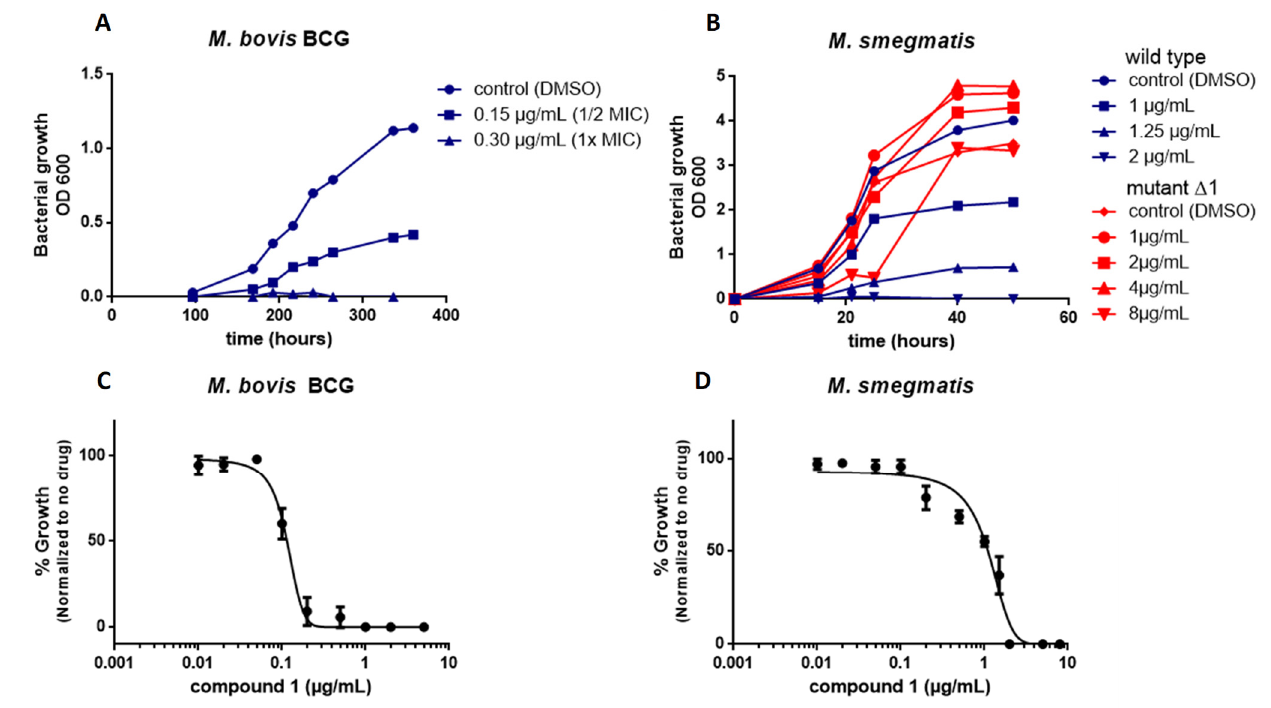
Figure 2. Compound 1 inhibits the growth of M. bovis BCG and M. smegmatis in vitro. All cultures were performed in 7H9 medium. ( A ) Growth curve of M. bovis BCG in the presence of various concentrations of compound 1 . ( B ) Growth curve of wild type M. smegmatis (blue) and the M. smegmatis resistant mutant ∆ 1 (red) in the presence of various concentrations of compound 1 . ( C ) Dose–response curves for the inhibition of M. bovis BCG by compound 1 . ( D ) Dose–response curves for the inhibition of M. smegmatis by compound 1 .